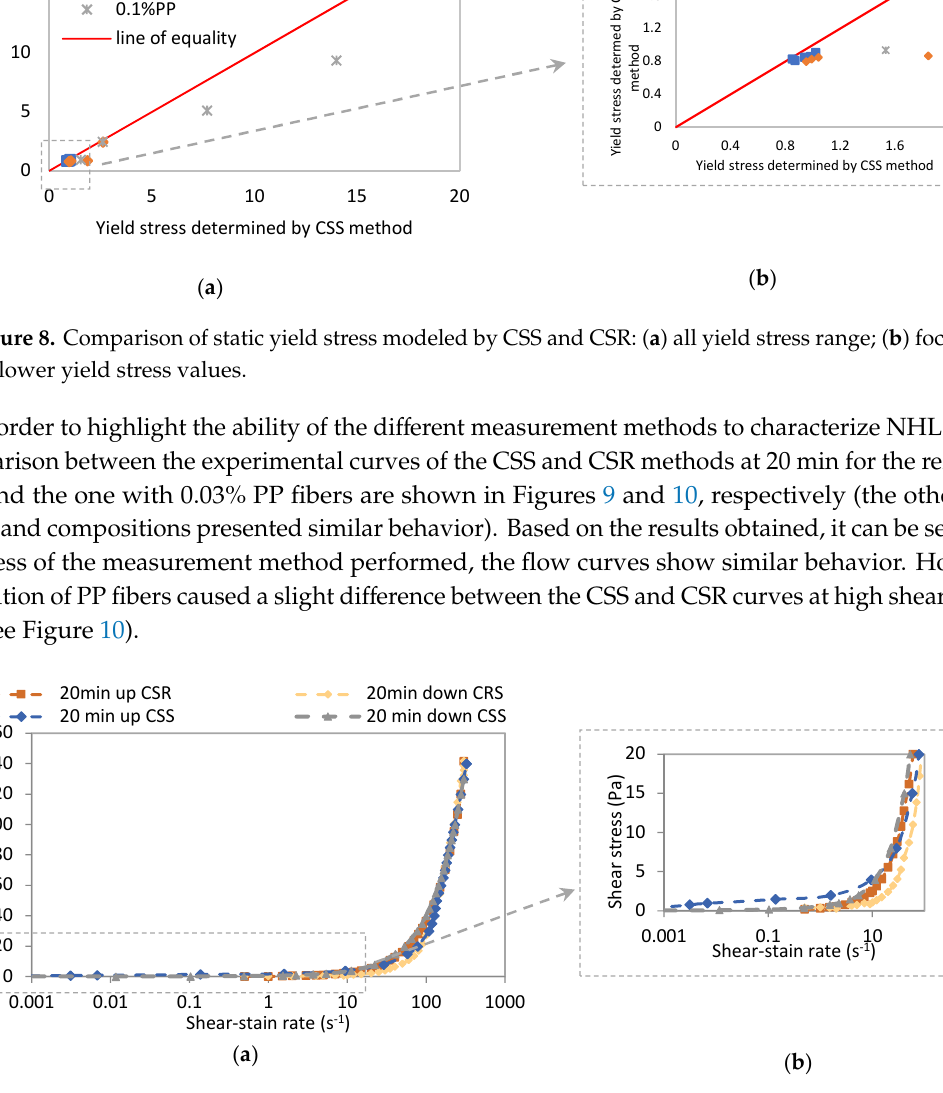
Figure 9. Flow curve obtained by CSS and CRS methods for the reference grout: ( a ) all shear-strain rate range; ( b ) focus on lower shear-strain rates.